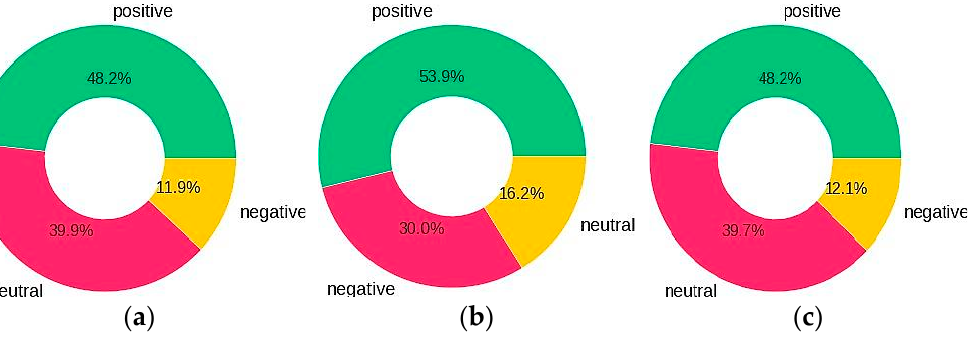
Figure 4. Percentage of tweets for: ( a ) COVID-19 vaccine; ( b ) post-Covid health factors; ( c ) health service providers.